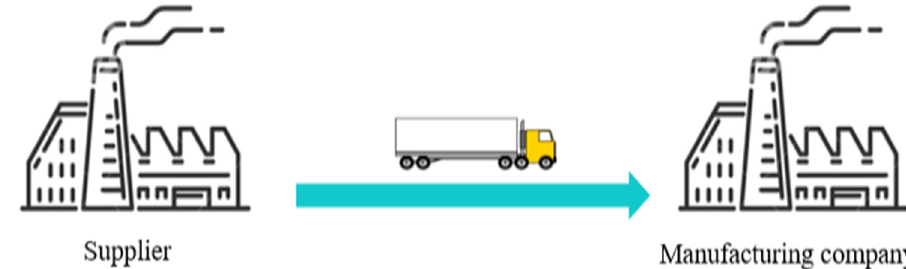
Figure 2: Direct transport diagram. Own source.